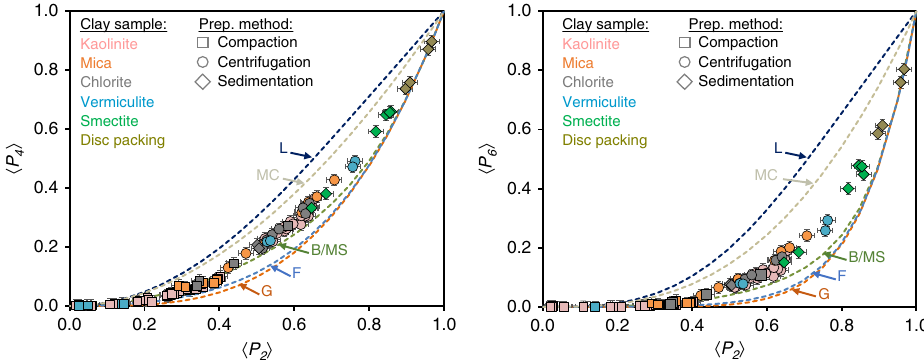
Fig. 2 Relationships between the experimental 〈 P 2 〉 , 〈 P 4 〉 , and 〈 P 6 〉 order parameters. Momenta of the experimental ODF for kaolinite, mica, chlorite, vermiculite, smectite, and arti fi cial clay samples made of disc packings 34 are shown in pink, orange, grey, blue, green, and dark green, respectively. Sample preparation based on compaction, centrifugation, and sedimentation methods are depicted by squares, circles, and diamonds, respectively. Experimental order parameters are compared with calculated parameters, with conventional Gaussian (G), Lorentzian (L), Fisher (F), Bingham/Maier-Saupe (B/MS), and mechanical compaction (MC) distribution models shown as orange, dark blue, light blue, green, and gray dotted